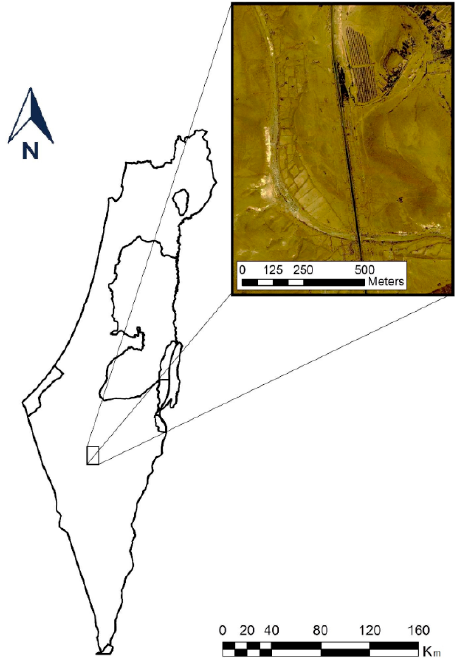
Figure 1. Map of Israel; research area enlarged.